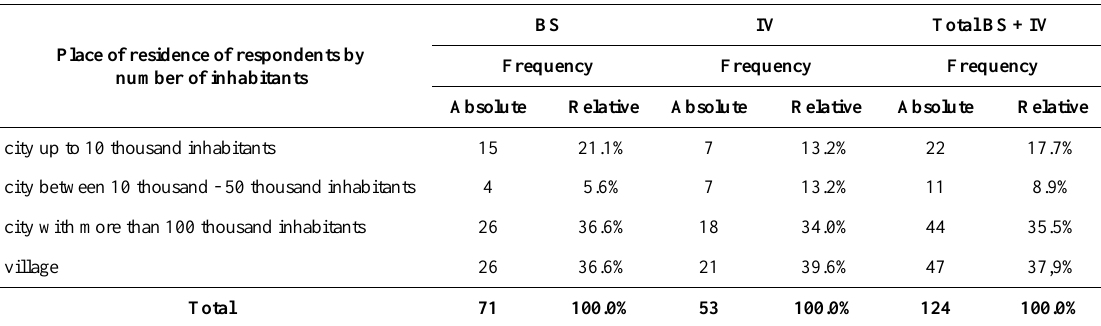
Table 2. Residence of